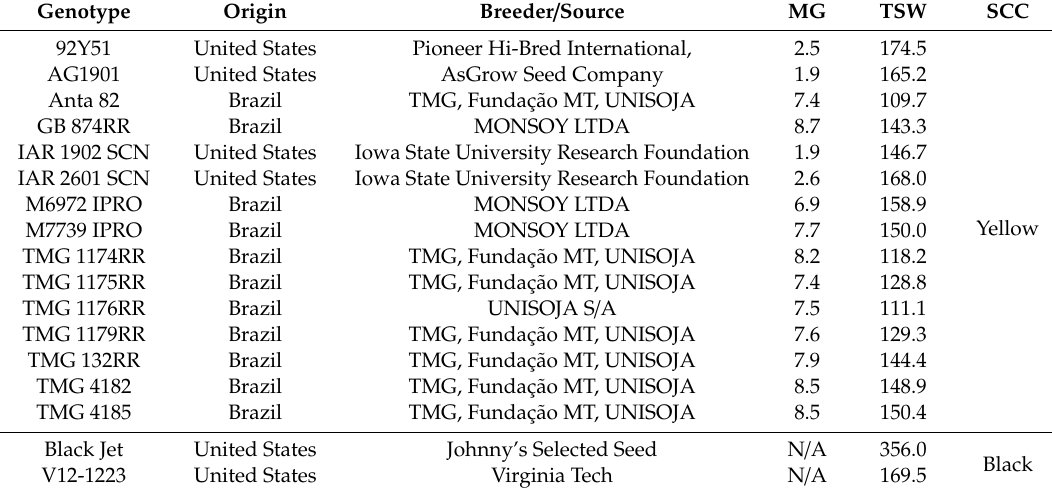
Table 2. Soybean genotypes, the origin of production and seed source maturity group (MG), thousand-seed weight in grams (TSW) used to evaluate seed coat permeability to fluorescent tracers, and seed coat color